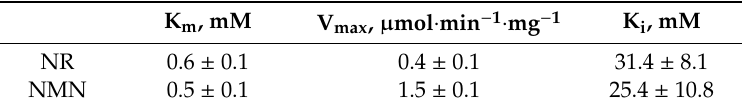
Table 2. Apparent K m, K i and V max values of the NadR-catalyzed reaction for nicotinamide mononucleotide (NMN) and nicotinamide riboside (NR) in presents of constant concentration ATP (10 mM).